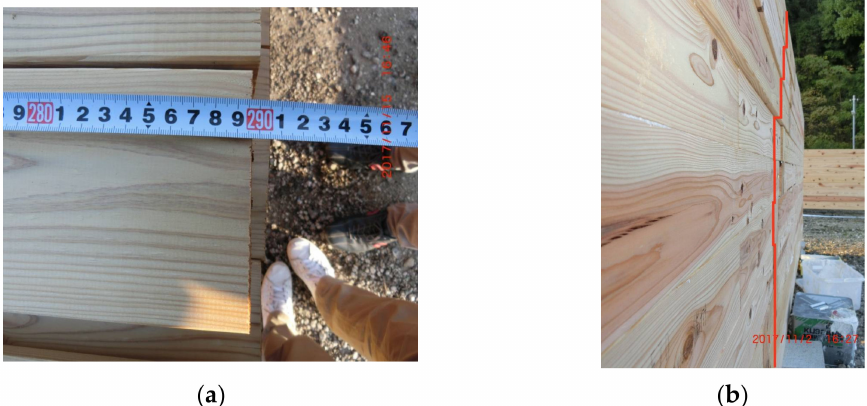
Figure 15. Manual construction site photos: ( a ) the cutting results will deviate from the required dimensions: the actual cut size of the timber with the design size of 2900 mm is 2896 mm. ( b ) The facade is displaced during the erection process, making the wall surface not flat